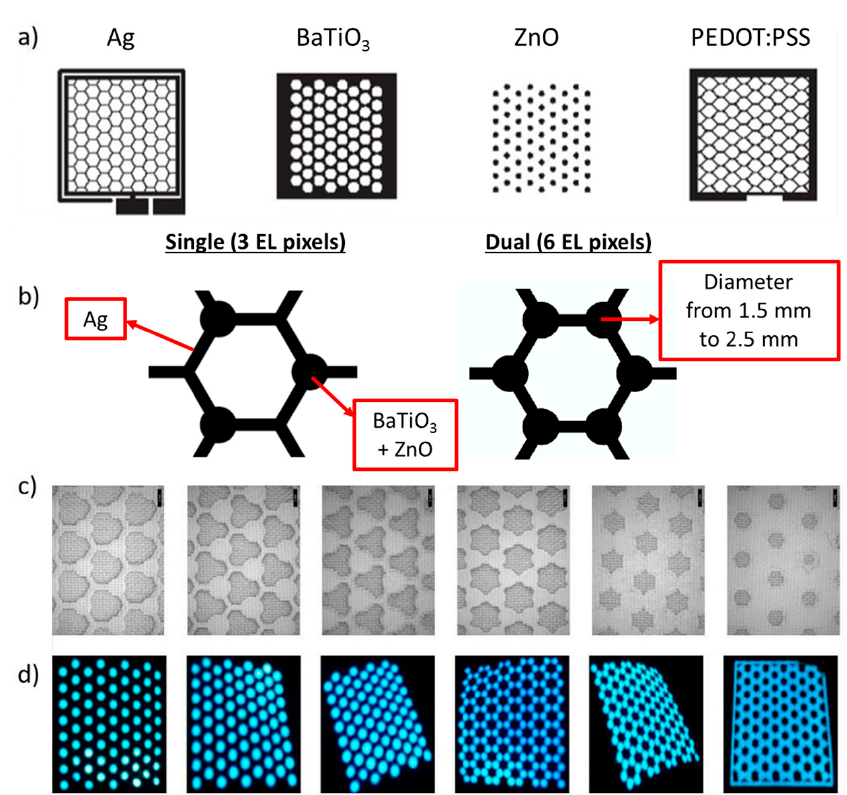
Figure 1. ( a ) Design of the single layers of the ACPEL (alternating current powder electroluminescence) build-up; ( b ) a zoom on a hexagon cell, showing clearly the applied size and number of the pixels; ( c ) SEM (Scanning electron microscopy) micrographs of the different printed ACPEL devices; ( d ) images of the light-emitting area of the ACPEL stacks.